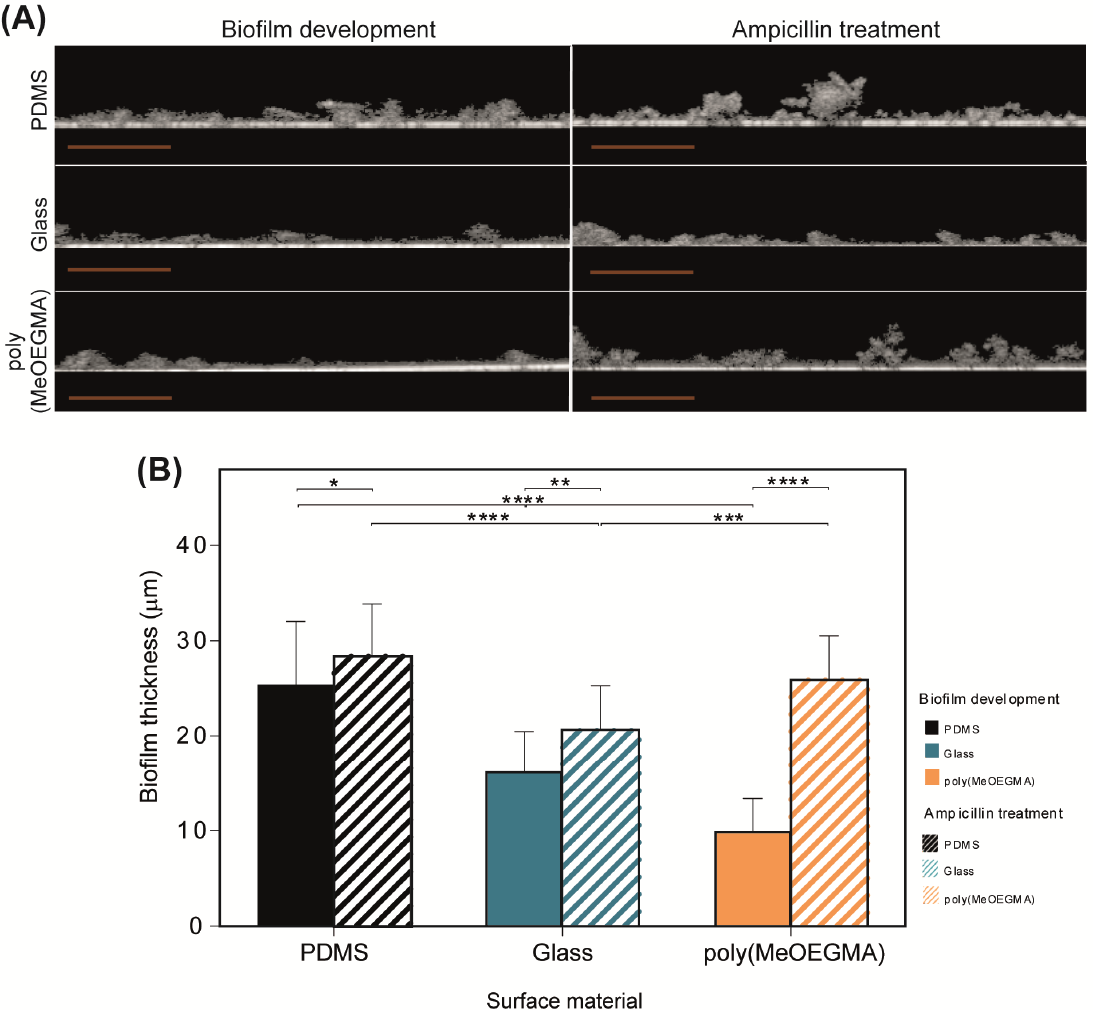
Figure 3. OCT analysis of biofilms formed on PDMS, glass and poly(MeOEGMA) brush: ( A ) Figure 1. Surface area fraction covered during biofilm development (up to 24 h) and ampicillin Figure 1. Surface area fraction covered during biofilm development (up to 24 h) and ampicillin representative 2D-cross-sectional views of biofilm structures (orange scale bars correspond to 200 ■ ■ treatment for an additional 8 h period (32 h) on polydimethylsiloxane (PDMS) ( and , treatment for an additional 8 h period (32 h) on polydimethylsiloxane (PDMS) ( and , ■ 200 µ m), and ( B ) biofilm thickness after biofilm development and ampicillin treatment on PDMS ( (cid:4) and Figure 1. Surface area fraction covered during biofilm development (up to 24 h) and ampicillin µm), and ( B ) biofilm thickness after biofilm development and ampicillin treatment on PDMS ( and ■ treatment for an additional 8 h period (32 h) on polydimethylsiloxane (PDMS) ( and , respectively), glass ( ■ and , respectively), and poly(MeOEGMA) brush ( ■ and , respectively). respectively), glass ( ■ and , respectively), and poly(MeOEGMA) brush ( ■ and , respectively). , respectively). ■ ■ and , respectively) and poly(MeOEGMA) brush ( and , respectively). , respectively), glass ( Standard deviations for three independent samples are presented. Statistical significance for all the Standarddeviationsobtainedfromthreereplicatesofeachsamplearerepresented. Statisticalsignificance Standard deviations for three independent samples are presented. Statistical significance for all the respectively), glass ( ■ and , respectively), and poly(MeOEGMA) brush ( ■ and , respectively). Standard deviations obtained from three replicates of each sample are represented. Statistical surfaces at each time point was determined by one-way ANOVA followed by Tukey’s multiple- was determined by one-way ANOVA followed by Tukey’s multiple-comparison test (**** for p < surfaces at each time point was determined by one-way ANOVA followed by Tukey’s multiple- significance was determined by one-way ANOVA followed by Tukey’s multiple-comparison test ( **** comparison test ( **** for P < 0.0001, and ** for P < 0.01). comparison test ( **** for P < 0.0001, and ** for P < 0.01).